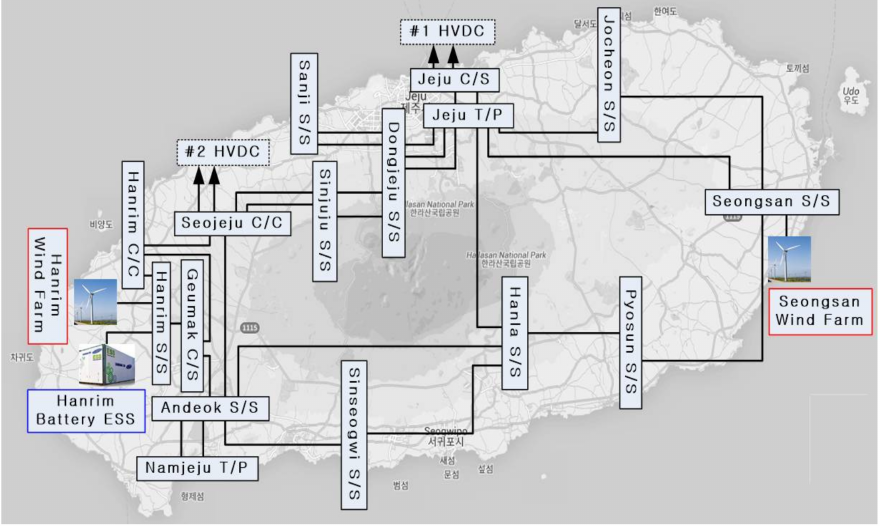
Figure 1. Jeju island power system with wind farms and battery